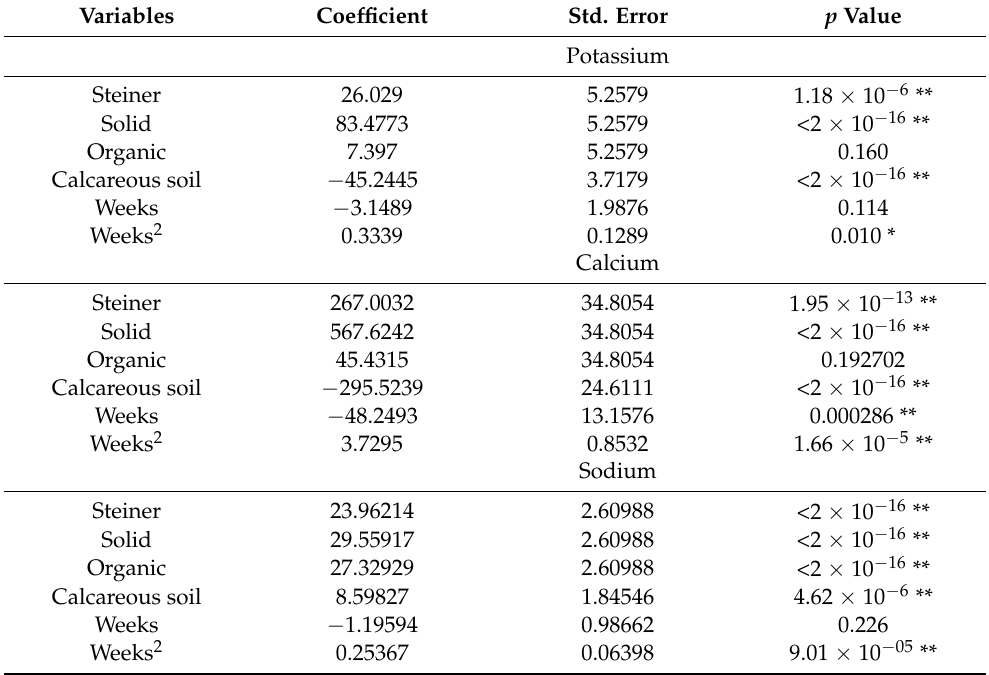
Table 7. Multiple polynomial model between the content of potassium, calcium, sodium, and three variables: two explanatory variables (treatment and soil type) and one numerical variable (weeks) of quadratic degree. The reference treatment for the comparison of the different nutrient contribution scenarios was irrigation water, while the forest soil was used as a reference to compare it against the calcareous